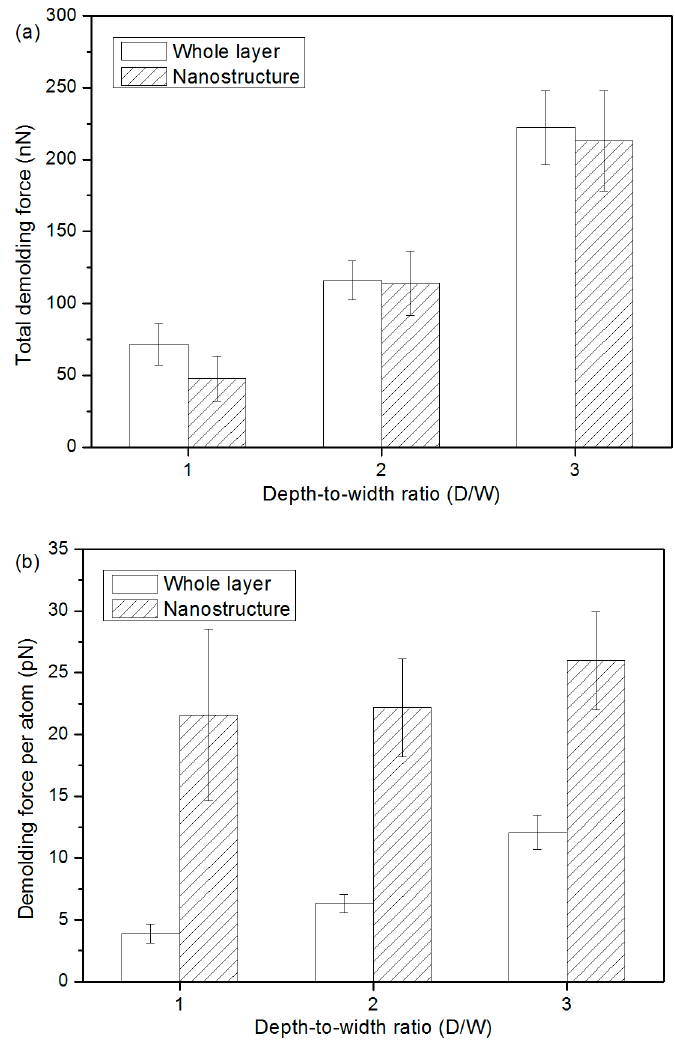
Figure 10. Demolding forces for different D/W, ( a ) the total demolding force and ( b ) the force per atom were calculated as an average value during the simulation time from 0.3 to 0.4 ps, when the highest demolding force occurs.